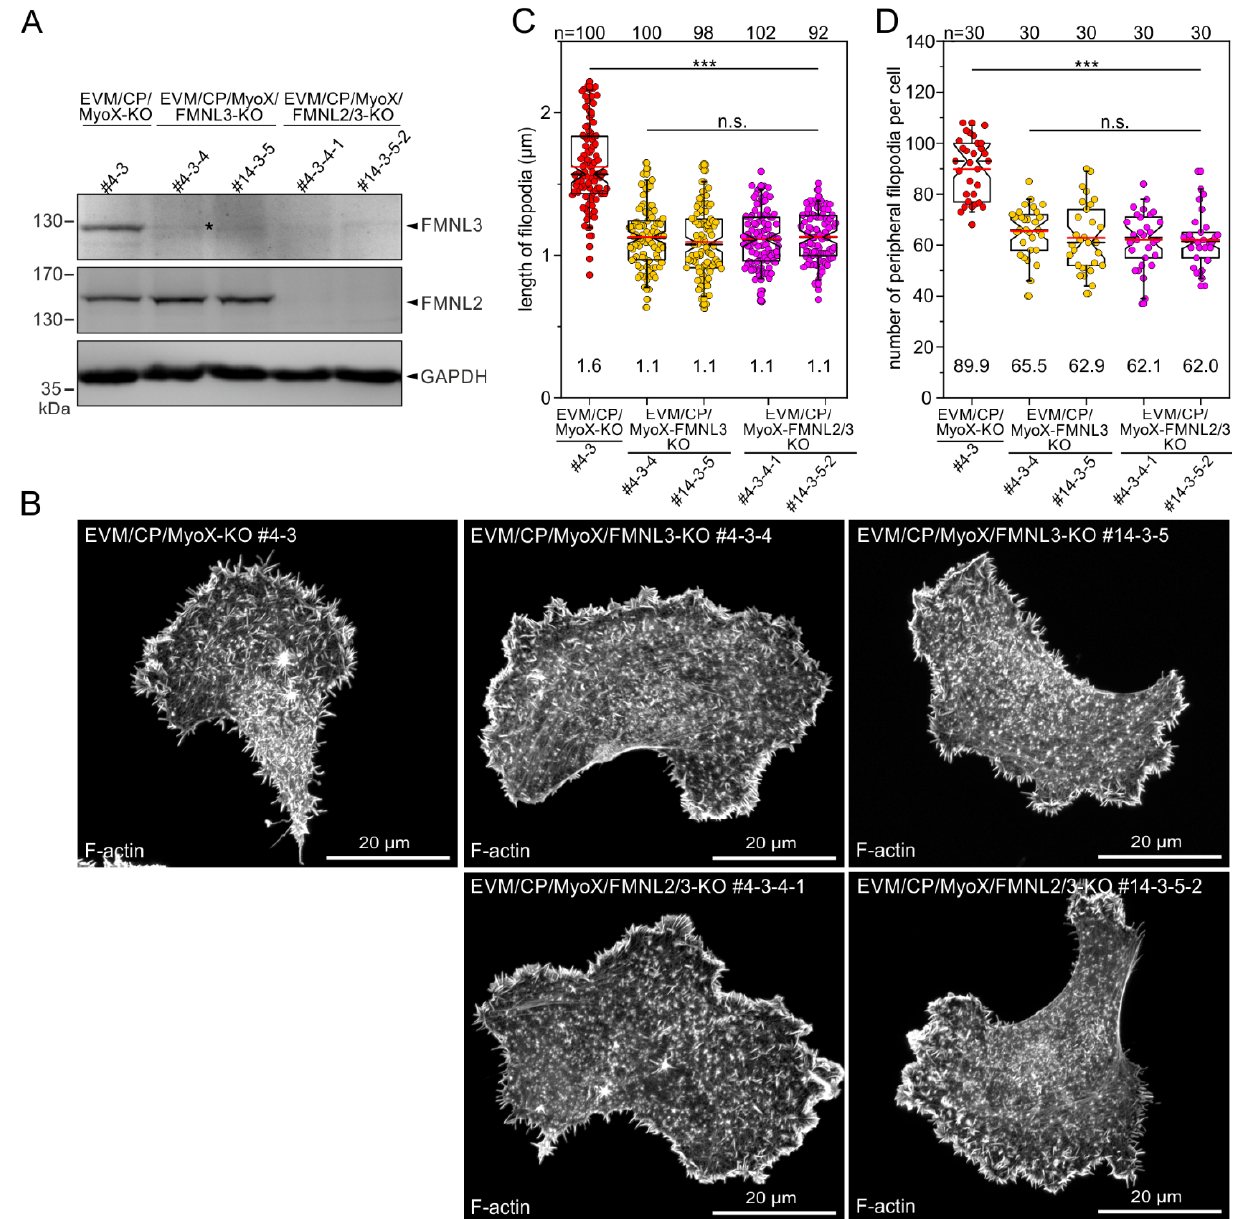
Figure 9. Additional inactivation of FMNL-family formins in EVM/CP/MyoX-KO cells affected not only the length but also the number of formed filopodia. the elimination of FMNL3 or FMNL2 and -3 in two independent EVM/CP/MyoX/FMNL3 or EVM/CP/MyoX/FMNL2/3 mutants (clones #4-3-4 and #14-3-5 or #4-3-4-1 and #14-3-5-2, respectively). The asterisk indicates a nonspecific band, as shown in more detail in Figure S8. Loading control: GAPDH. ( B ) Representative images of mutant cells indicated migrating on laminin and stained for the F-actin cytoskeleton with phalloidin. ( C ) Comparison of filopodium length in respective cell line. ( D ) Quantification of the number of peripheral filopodia in mutants as indicated. ( C , D ) The boxes in box plots indicate 50% (25–75%) and whiskers (5–95%) of all measurements, with dashed black lines depicting the medians and arithmetic means highlighted in red. ( C ) Non-parametric Kruskal–Wallis test and Dunn’s Multiple Comparison test and ( D ) one-way ANOVA and Tukey Multiple Comparison test were used to reveal statistically significant differences between datasets. *** p ≤ 0.001; n.s.: not significant. n: number of filopodia ( C ) or cells ( D ) analyzed from three independent